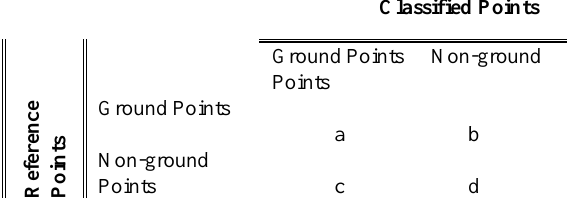
Table2. Structure of Confusion